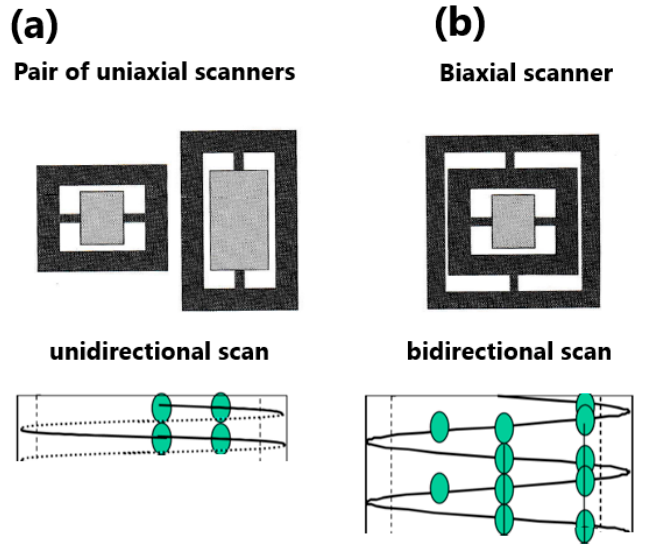
Figure 3. Schema of uniaxial scanner in ( a ) vs. biaxial scanner in ( b ) with associated scanning tra- jectories.